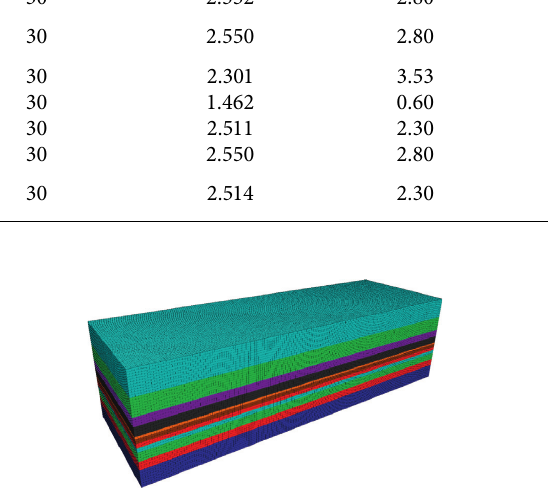
Figure 7: Numerical simulation model.